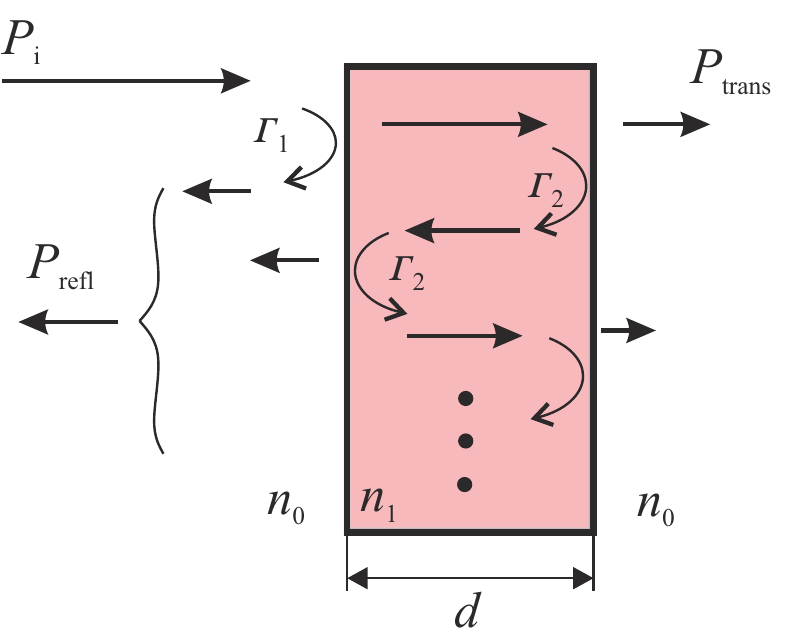
Figure 1. Schematical presentation of the wave interaction with a thin dielectric material